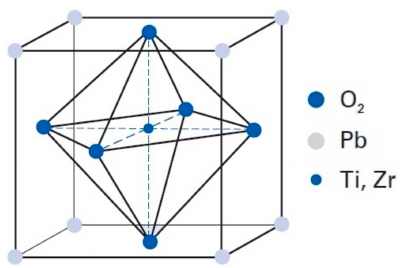
Figure 2. Tetragonal unit cell of soft piezo ceramic.